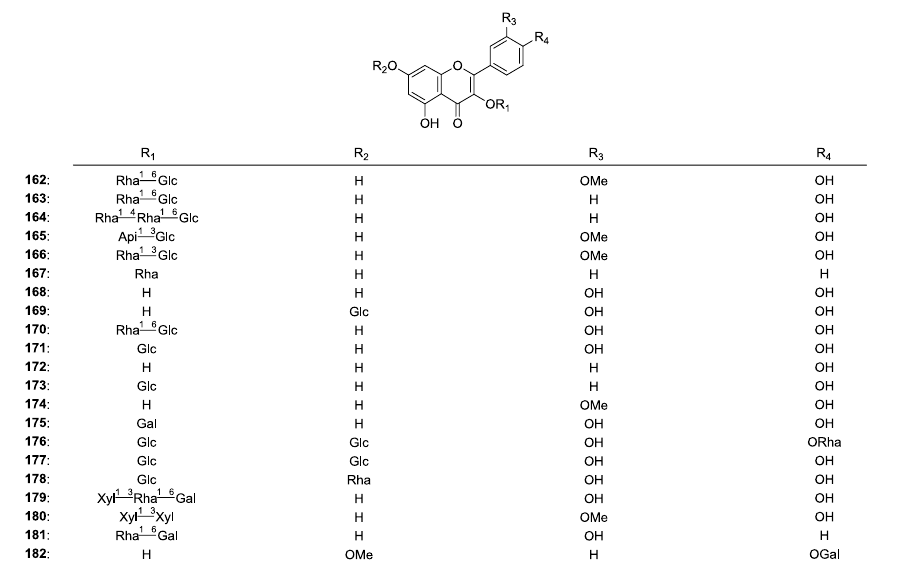
Figure 3. The structures of compounds 162 – 224 obtained from the Astragalus